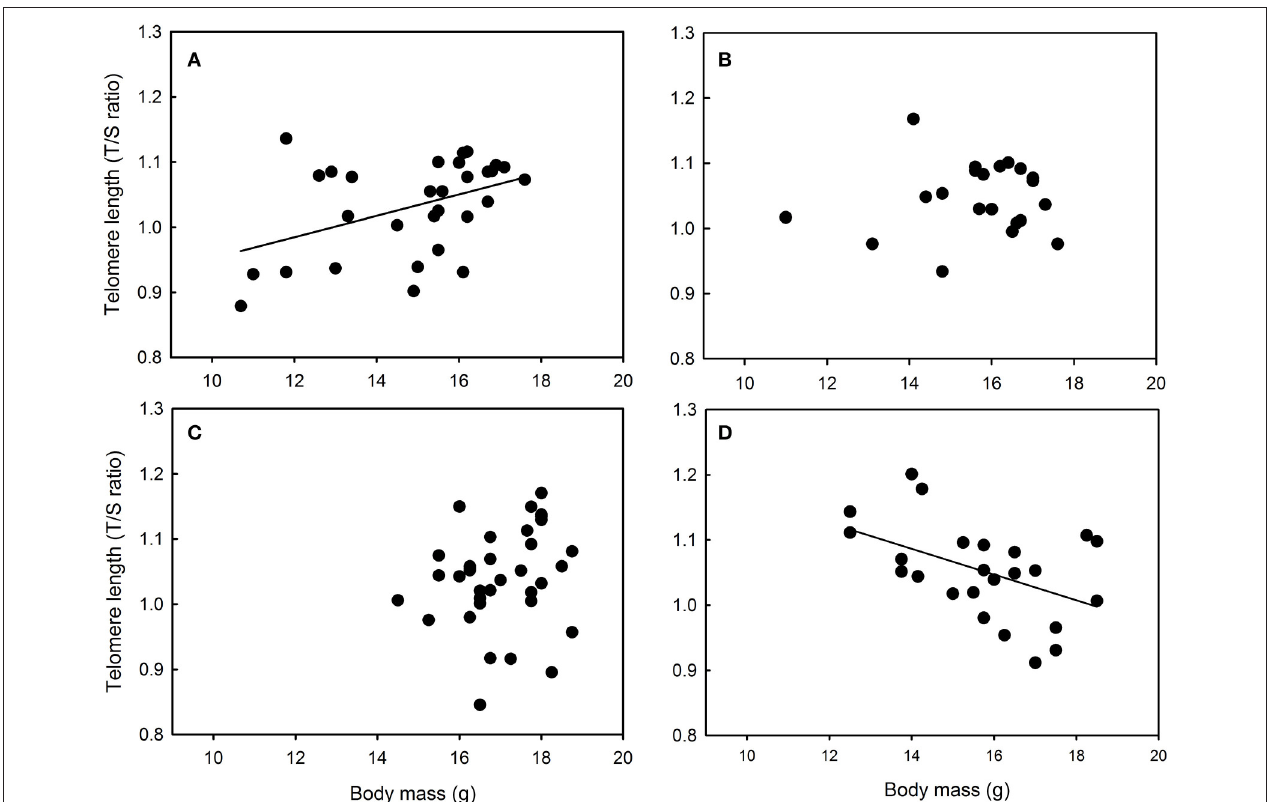
FIGURE 5 | Relationships between telomere length and body mass in great tit nestlings reared in (A) Chizé and (B) Niort, (C) Foljuif, and (D) Paris (see text for details of the